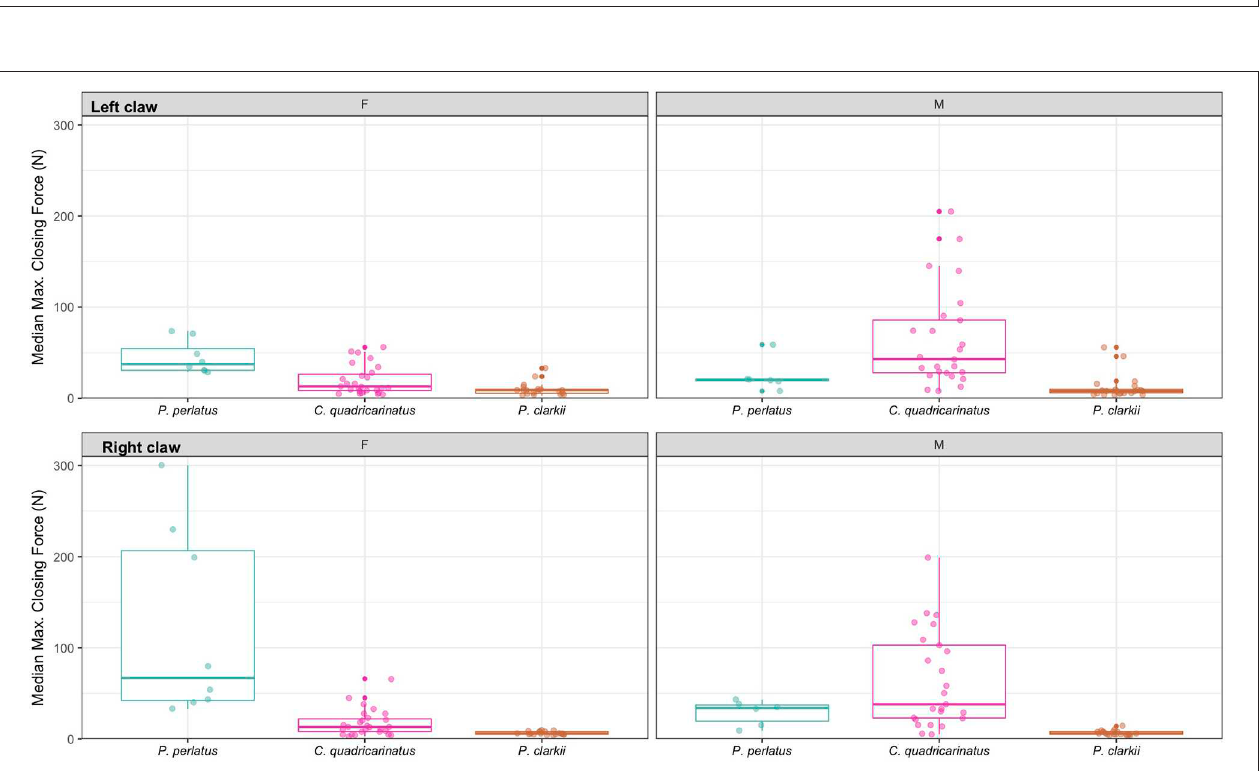
FIGURE 2 | Median maximum closing force (N) of left and right chelae of female and male P. perlatus , C. quadricarinatus , and P. clarkii. Individual points represent raw data. Boxplots represent median value and 25–75% interquartile range.